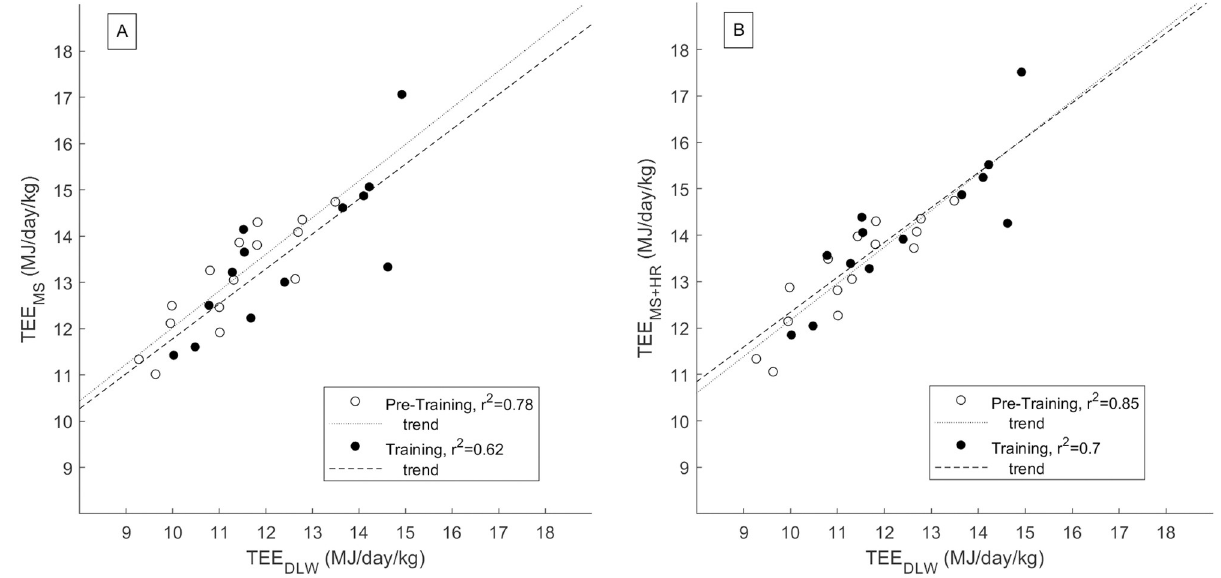
Fig 2. Wearable sensors data explain significant portion of the between-subject changes in DLW-assessed total energy expenditure. (A) Regression plot for DLW and Motion Sensor assessed Total Energy Expenditure (TEE DLW and TEE MS ). Open dots from the Control period (N = 15), closed dots from the Training period (N = 13). (B) Corresponding plot when the motion sensor data is replaced by heart rate monitor data during exercise sessions (TEE MS+HRM ). In A and B, resting energy expenditure was estimated using body weight and age [35].